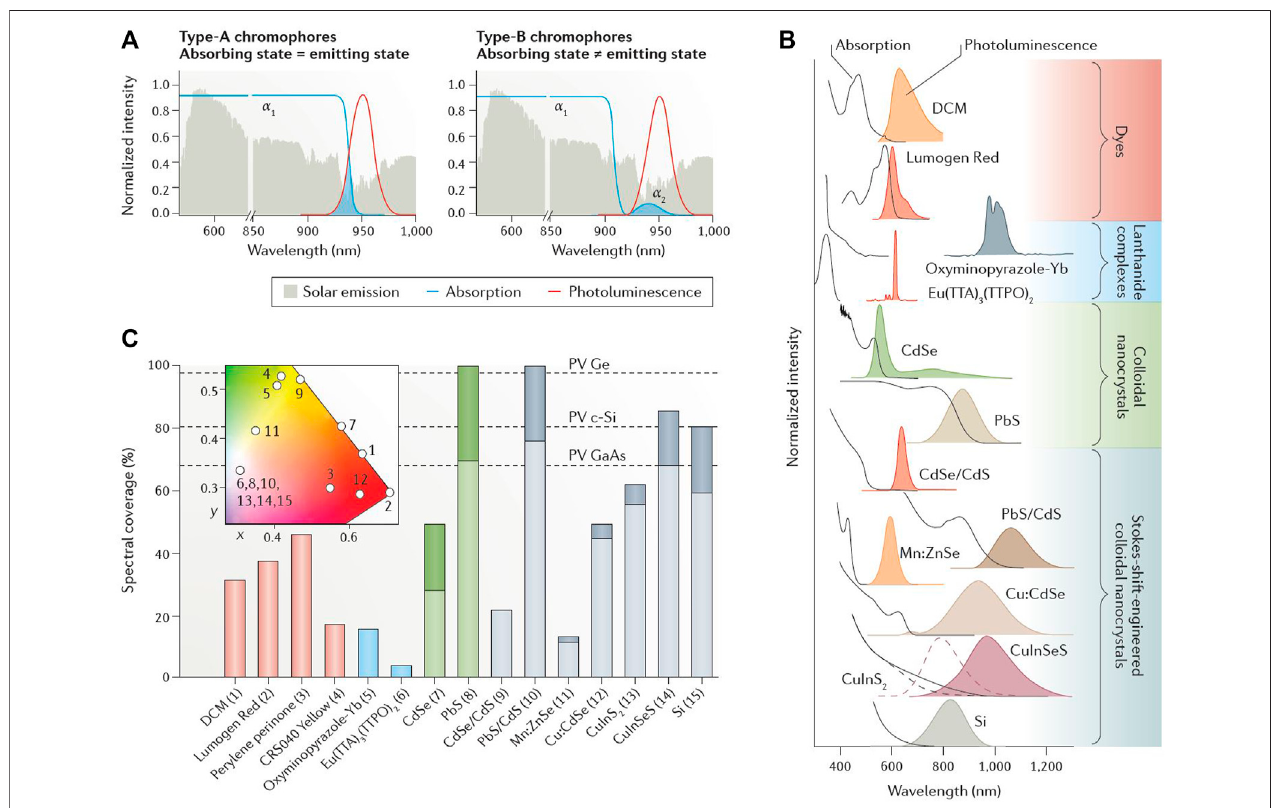
FIGURE 6 | (A) Type-a and Type-b chromophores absorbance and emission state (B) normalized intensity (C) spectral coverage % of PbS, CdSe, Lumogen red, and Eu